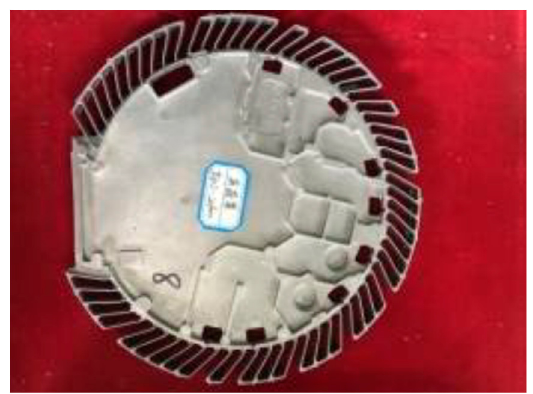
Figure 11. 6063 Al telecom part farbricated by the RheoMetal [130].